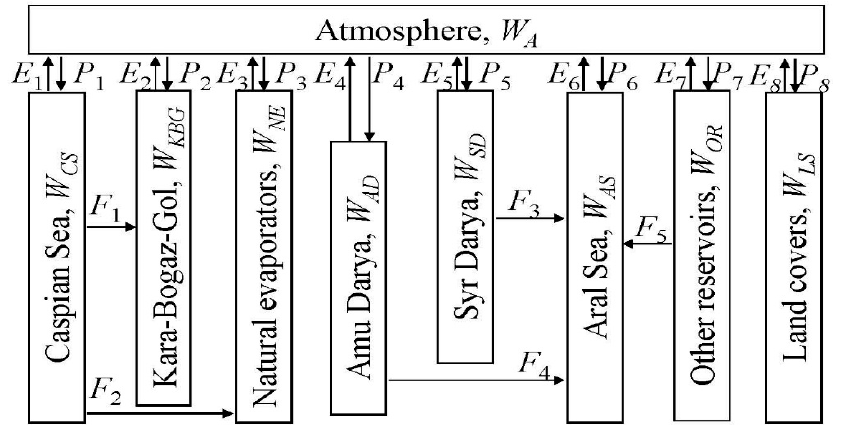
Figure 2. Principal block-scheme of main water cycle components in the Aral Sea zone.